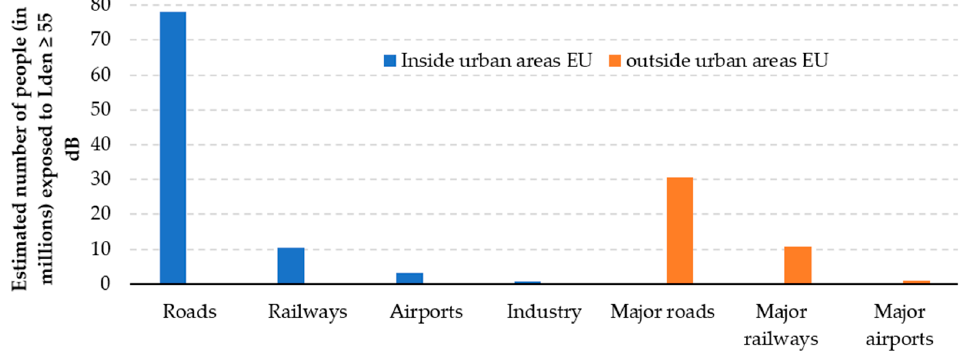
Figure 6. Number of people exposed to average day–evening–night noise levels (Lden) ≥ 55 db in Europe, 2019 [13].